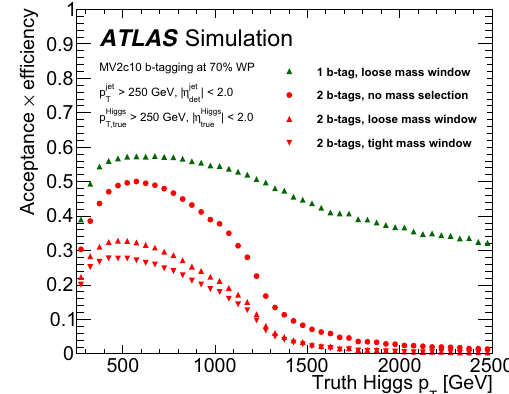
Fig. 6 The Higgs boson acceptance times efficiency is shown for a few working points: the double and single b -tagging with the loose mass window requirement and the double b -tagging with the tight, loose and no mass window requirements